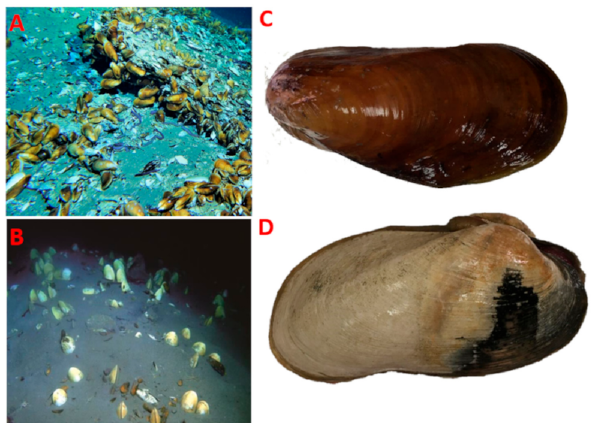
Figure 1. Photograph of the two species of bivalves Gigantidas haimaensis and Archivesica marissinica from Haima cold seep. The in situ photo showing the population of G. haimaensis ( A ) and A. marissinica ( B ). The photo of single G. haimaensis ( C ) and A. marissinica ( D